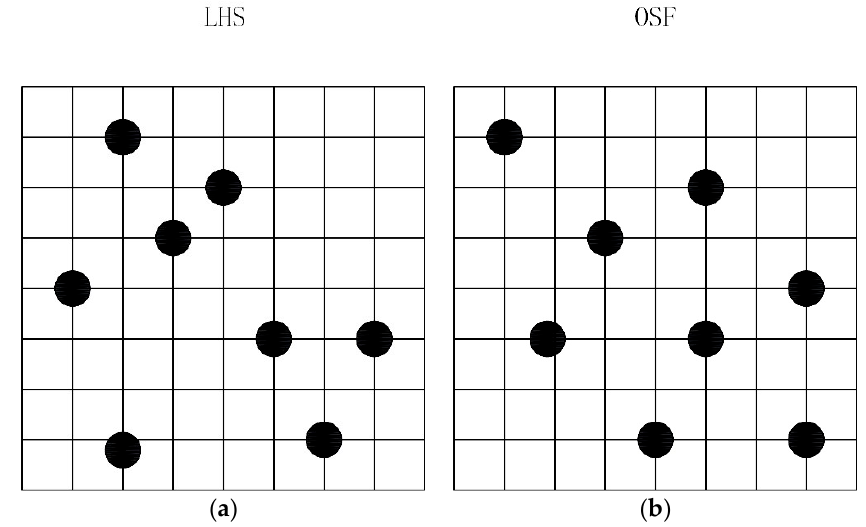
Figure 5. Design of experiments (DOE) method. ( a ) Latin hypercube sampling algorithm (LHS); ( b ) optimum space filling algorithm (OSF). ( b ) optimum space filling algorithm